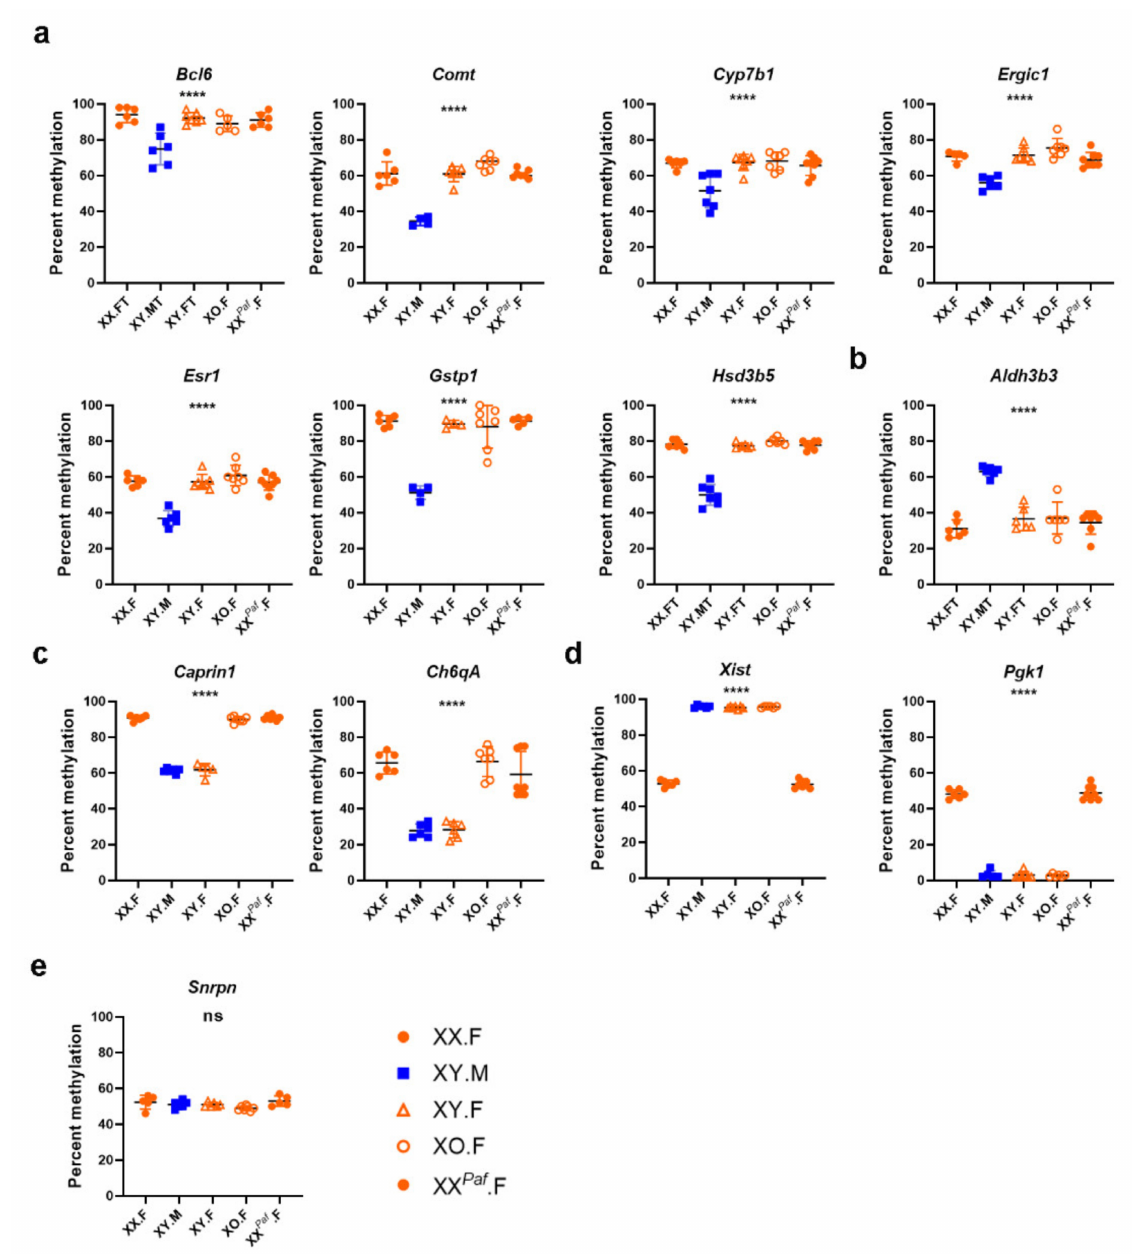
Figure 3. Validation of sex-associated di ff erentially methylated regions (sDMRs) using pyrosequencing assays. ( a ) Autosomal sDMRs with higher methylation in females ( Bcl6 , Comt , Cyp7b1 , Ergic1, Esr1 , Gstp1, and Hsd3b5 ). ( b ) Higher methylation in males ( Aldh3d3 ). ( c ) Lower methylation in carriers of an Y chromosome ( Caprin1 and Ch6qA1). ( d ) X-linked sDMRs ( Xist and Pgk1 ) where methylation levels depend on X-chromosome dosage. ( e ) Methylation levels at the imprinted Snrpn DMR are similar across all groups. Each point corresponds to one DNA sample. Error bars show standard deviation, asterisks denote statistically significant di ff erences in methylation levels between groups (one-way analysis of variance (ANOVA)): **** p < 0.0001, ns—not